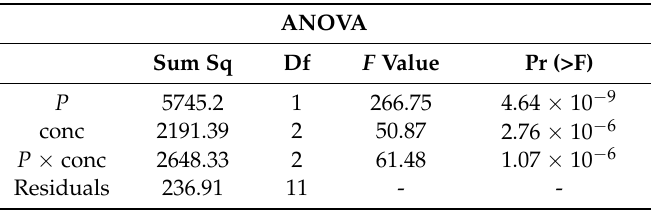
Table 4. Statistical analyses of mitochondrial respiratory activity. The effects of the particle (P), the concentration, and their interaction on the changes in respiratory activity were analyzed with a two-way analysis of variance. A p value of ≤ 0.05 was considered significant. Mean pairwise comparisons were computed with a Tukey’s test ( α = 0.05). All analyses were performed with the R software version 3.4.2 (R Core Team, Vienna, Austria,